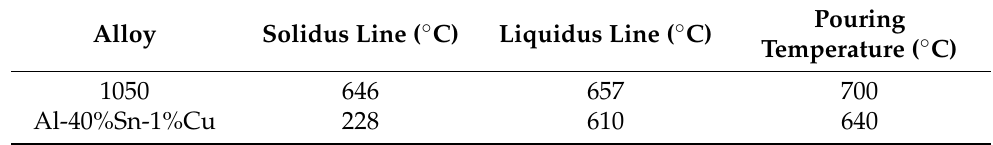
Table 3. Solidus lines, liquidus lines, and pouring temperatures of 1050 and Al-40%Sn-1%Cu.